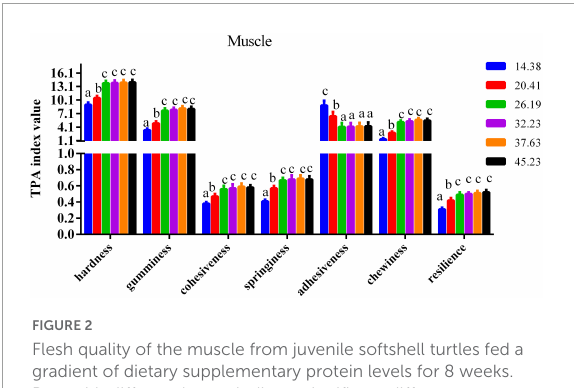
FIGURE2 Flesh quality of the muscle from juvenile softshell turtles fed a gradient of dietary supplementary protein levels for 8 weeks. Bars with different letters indicate significant differences among the groups ( P < 0.05). The values shown are the mean ± SD for three replicates.